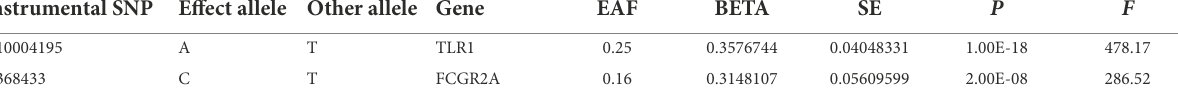
TABLE 2 Instrumental SNPs of H. pylori infection and F statistics. Instrumental SNP Effect allele Other allele